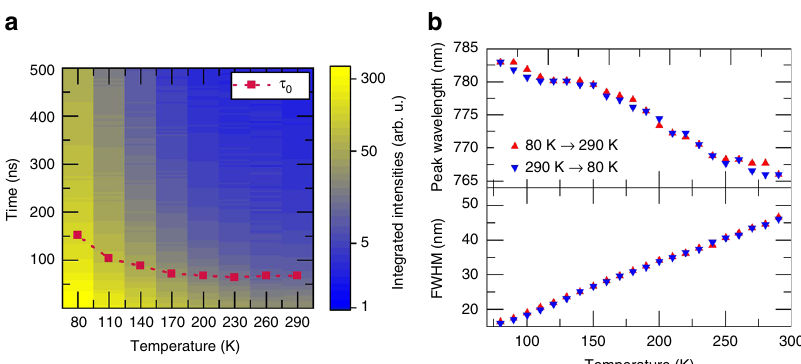
Fig. 2 Temperature-dependent PL properties. a Transient PL images showing the integrated intensity as a function of time after fs-excitation and temperature at an excitation fl uence of 60 nJ cm − 2 . The red dots denote the carrier lifetime τ 0 de fi ned as the time when the integrated intensity dropped to 1/e of its initial intensity. The dotted line is drawn as a guide to the eye. b Peak wavelength and FWHM of the thin fi lm PL. The blue symbols are extracted from the measurement while cooling down and the red symbols are extracted while heating